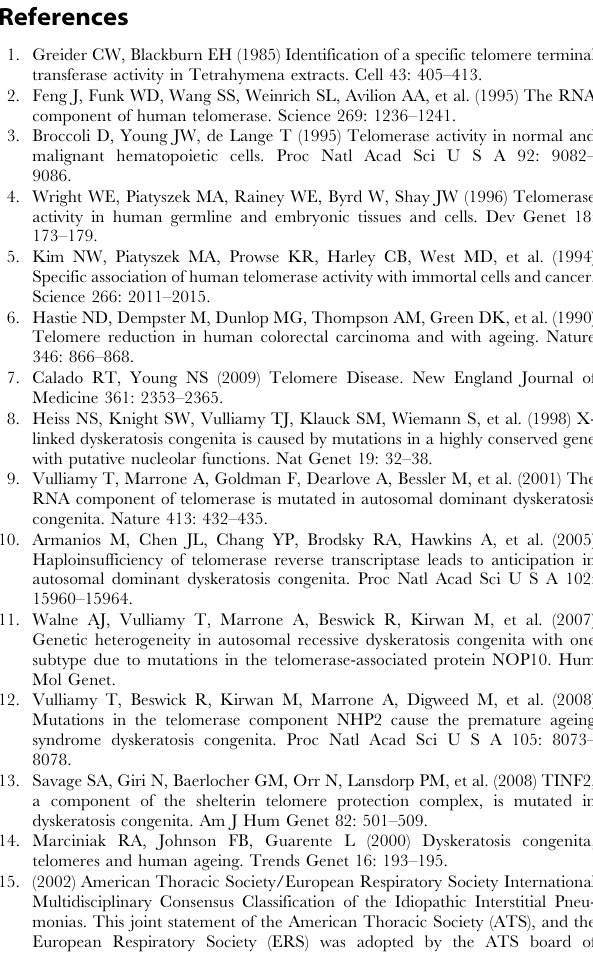
Figure S2 Correlation between telomere lengths measured by Southern blot (TRFL, kb) and by multiplexed real-time PCR (Relative LN(T/S ratio)) for 387 different genomic samples. The Southern blot method for determining telomere length (Terminal Restriction Fragment Length Analysis) was performed as described [19]. A relative LN (T/S ratio) = 1 corresponds to a terminal restriction fragment length of 4.5 kb. By linear regression analysis, the correlation between the two are highly significant (Spearman’s rank correlation = 0.83, P-value , 2.2 6 10 2 16 ). Table S1 Distribution of TERT mutations for 134 heterozygous mutation